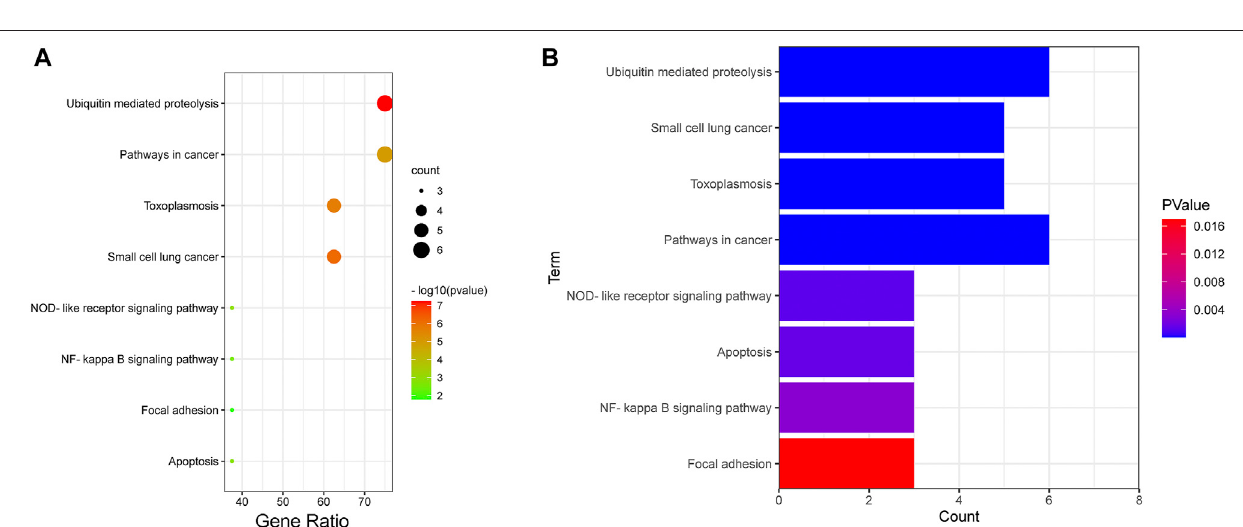
Frontiers in Genetics |